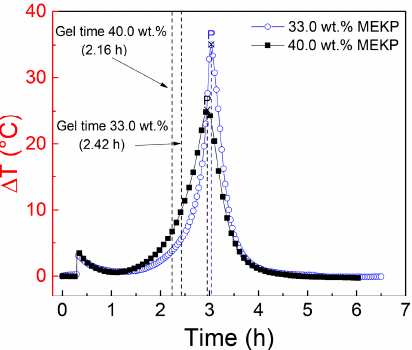
Figure 8. Curing thermograms of 14 mL of VER with 33 and 40 wt.% styrene